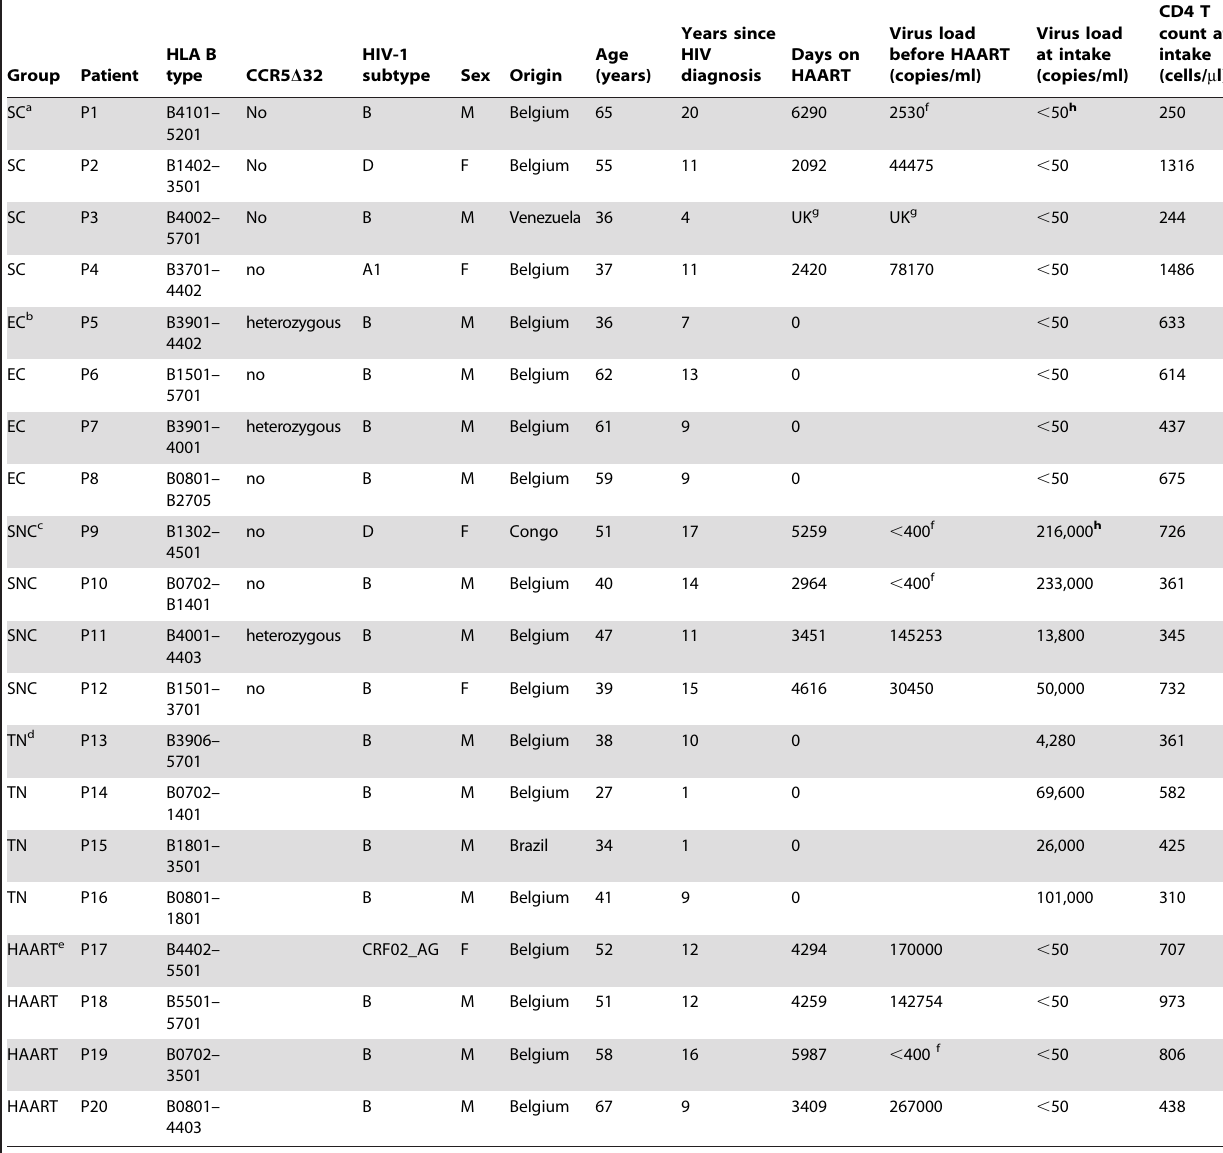
Table 1. Patients characteristics at enrollment